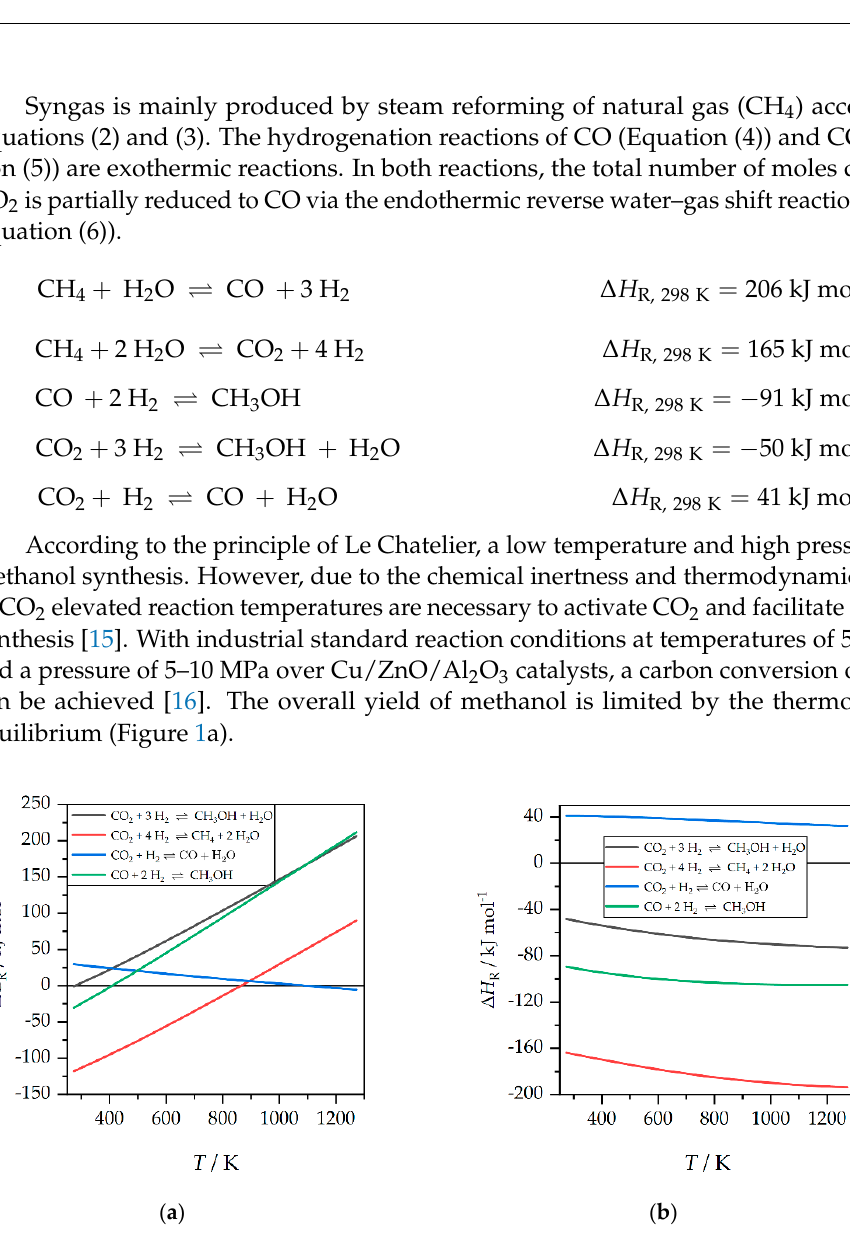
Figure 1. ( a ) Standard Gibbs free energies of reaction ( Δ G R0 ) for carbon dioxide (CO 2 ) hydrogenation to methanol and methane, reverse water gas shift reaction (RWGS), and carbon monoxide (CO) hydrogenation to methanol; ( b ) Enthalpies of reaction ( Δ H R ) for CO 2 hydrogenation to methanol and methane, RWGS, and CO hydrogenation to methanol; data calculated with HSC Chemistry 8 [17].